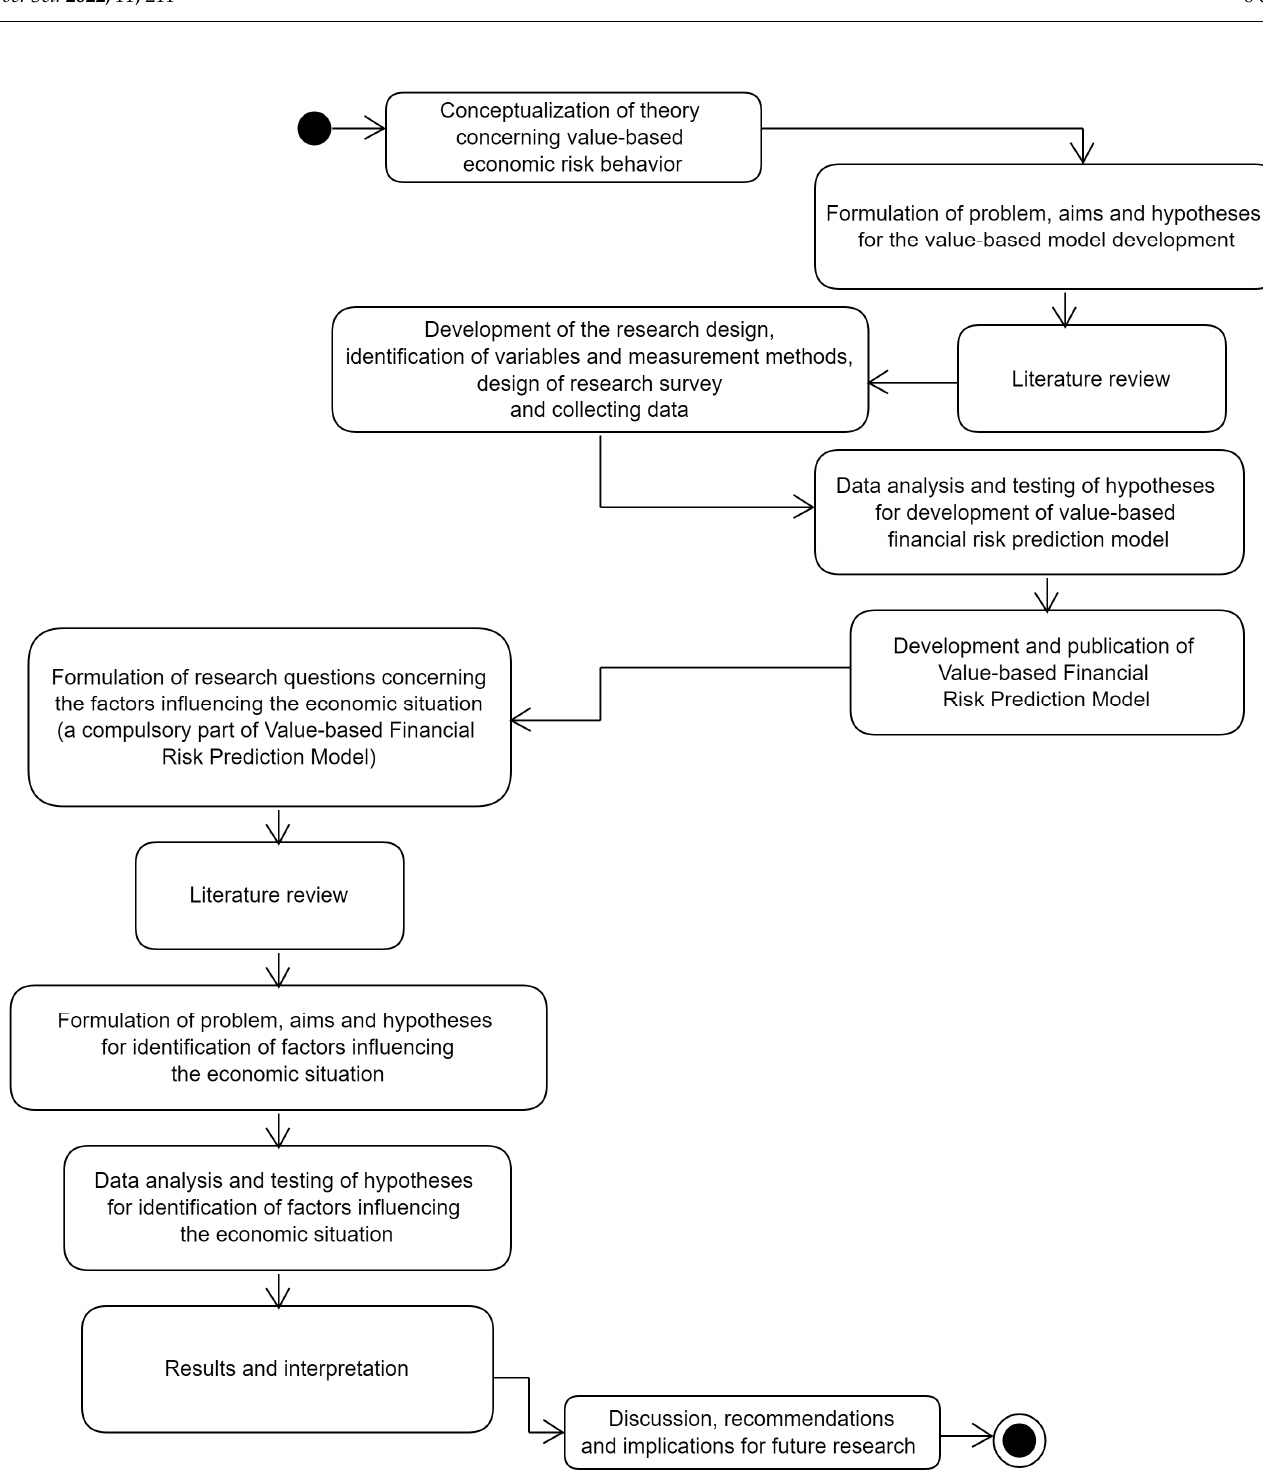
Figure 1. The research